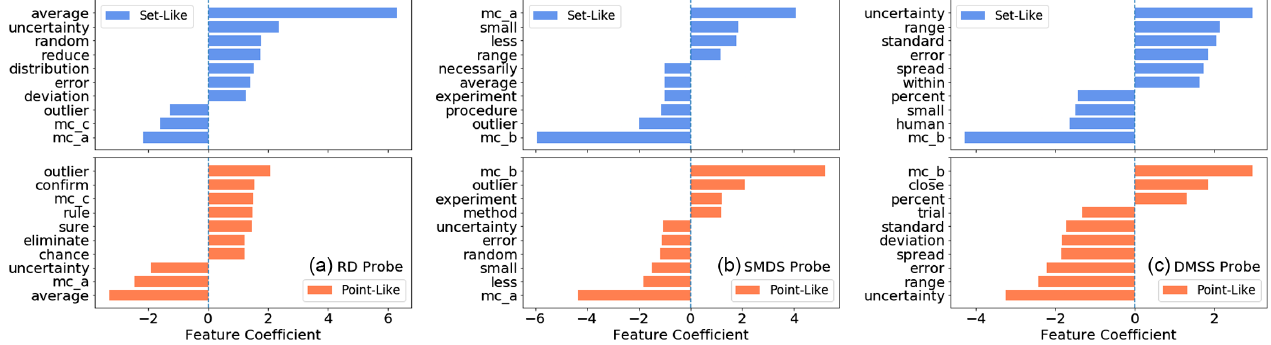
FIG. 9. The high-magnitude-coefficient features and their unpenalized beta coefficients for each probe. The vertical axis lists different features, or words, that are important in categorizing a student response. The horizontal axis shows their relative weight, or beta coefficient. The words mc_a, mc_b, and mc_c correspond to the selection of multiple choice answer A, B, and C,